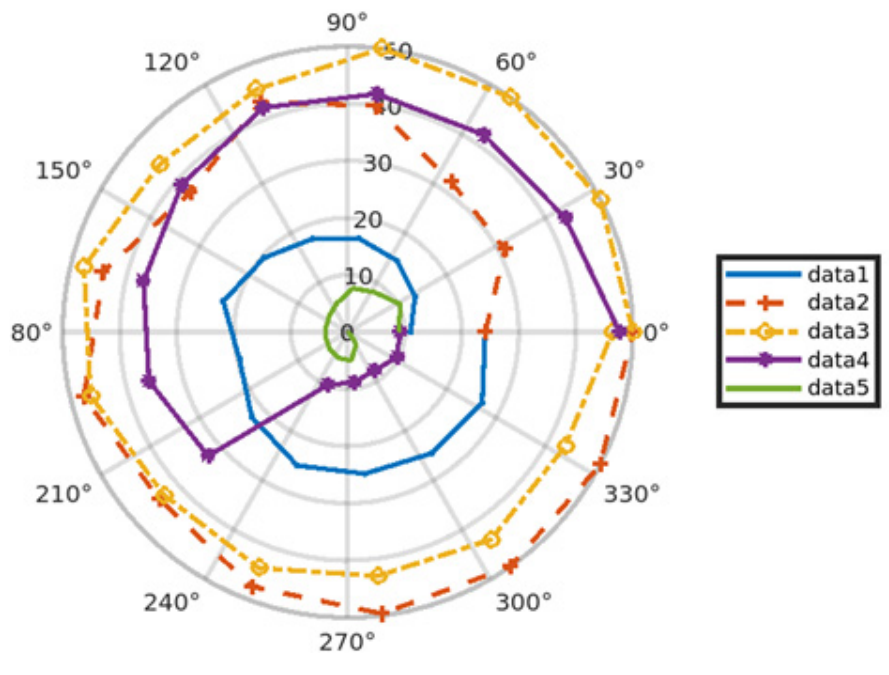
Figure 16. Patch Antenna RSSI.